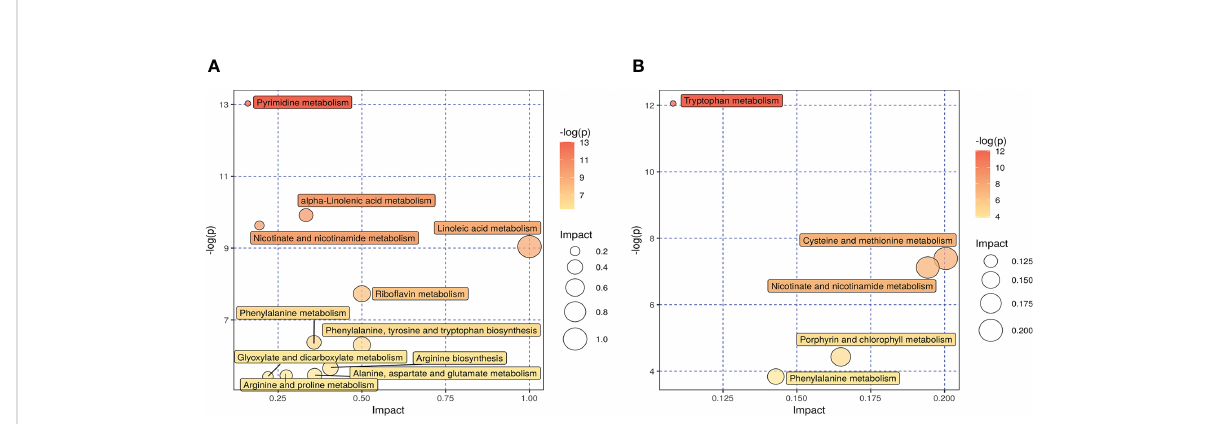
FIGURE 6 The effect of SADI-S on metabolic pathway in the negative ion mode (A) and in the positive ion mode (B) . The bigger the circle, the more signi fi cant is the enrichment. The darker the yellow, the smaller the P